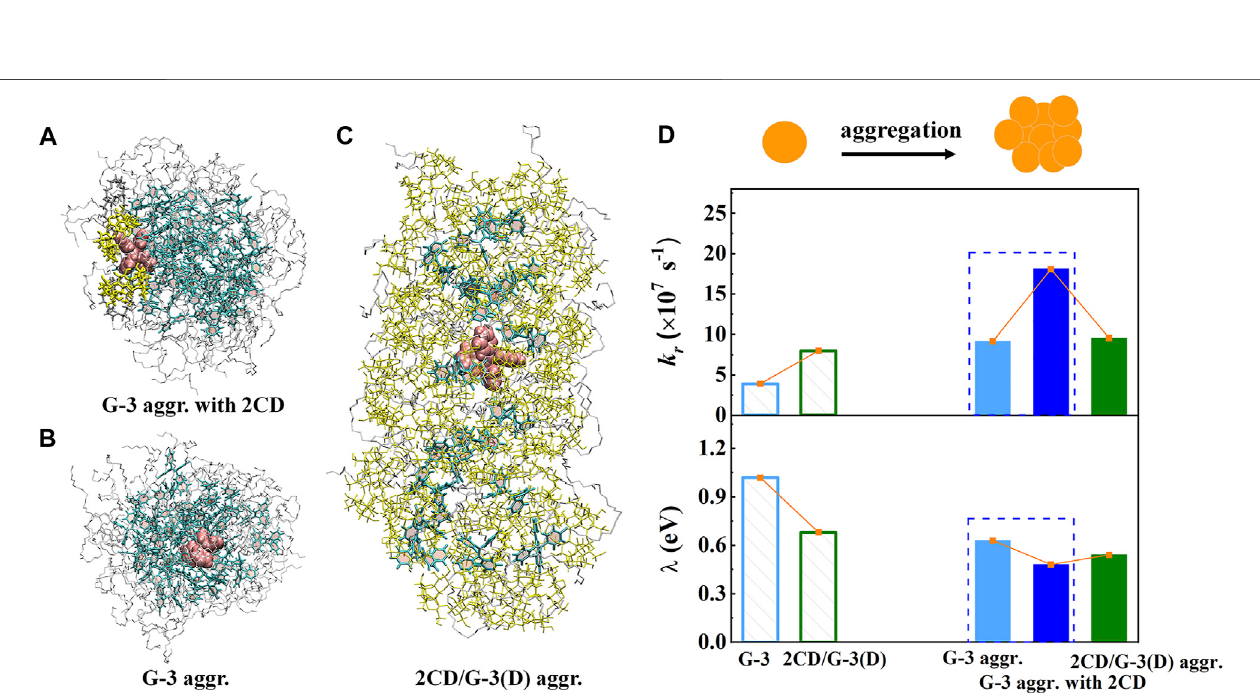
FIGURE 5 | (A – C) The QM/MM models for the G-3 aggregate, G-3 aggregate with 2CD, and 2CD/G-3D aggregate, respectively. To be shown more clearly, we take “ aggregate ” as the abbreviation “ aggr. ” here. (D) The calculated k r and λ of two monomers and three aggregates, respectively. (Reproduced with permission from Yang et al. (2021); Copyright 2021 The Royal Society of Chemistry).